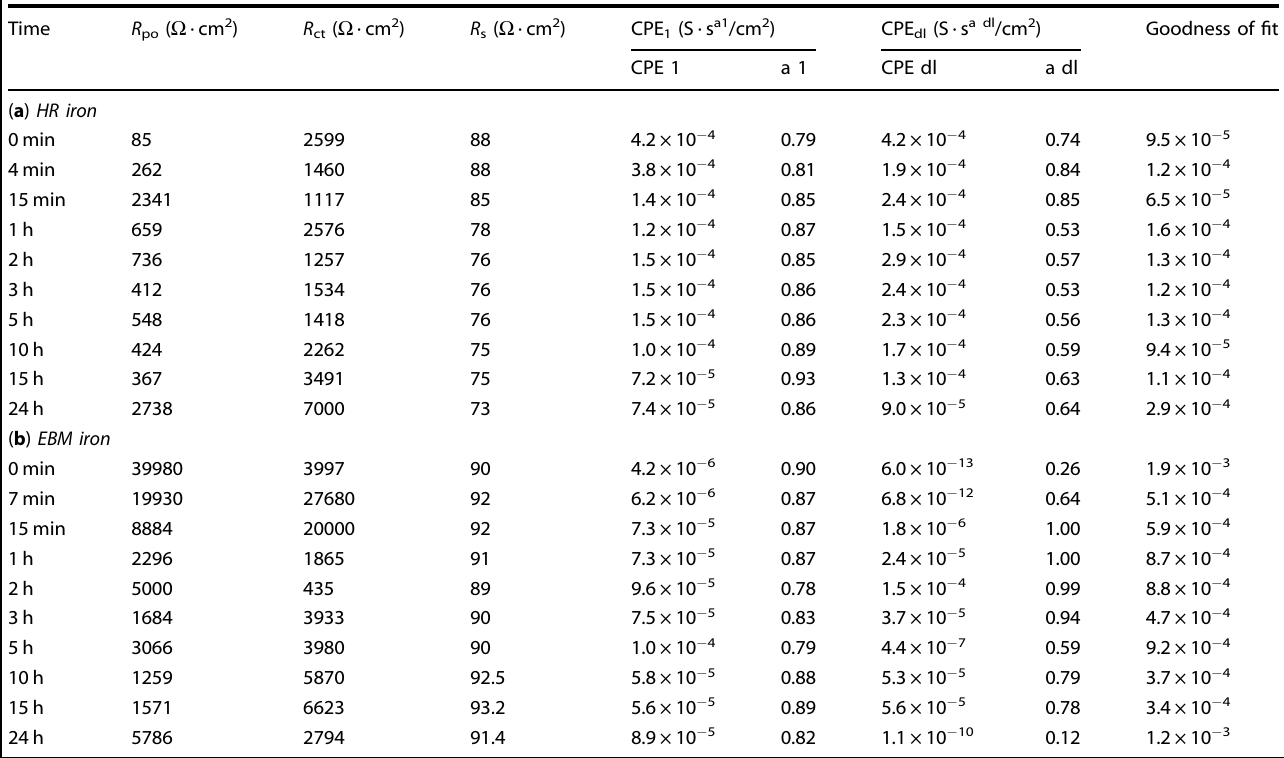
Table 1. Summary of the evaluated resistances and CPE from fi tting the EIS data shown in Fig. 10 for (a) HR iron and (b) EBM iron. Time R po ( Ω ∙ cm 2